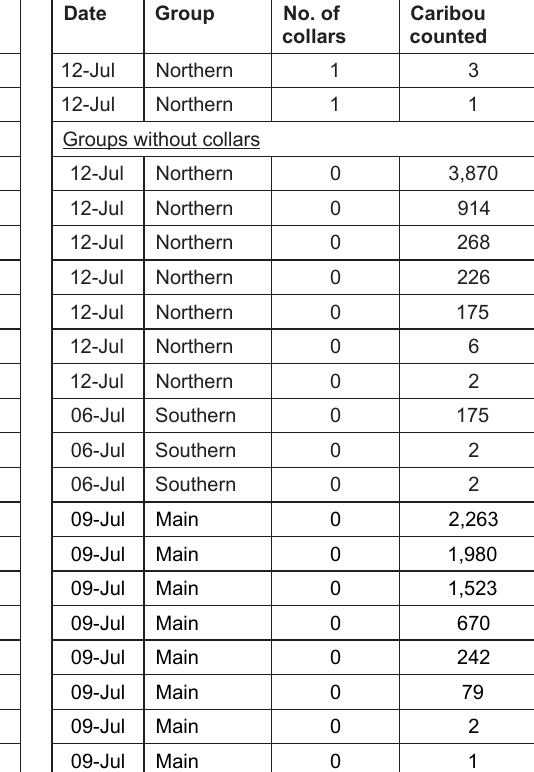
Table 4. Field data for the Bluenose East 2010 post-calving